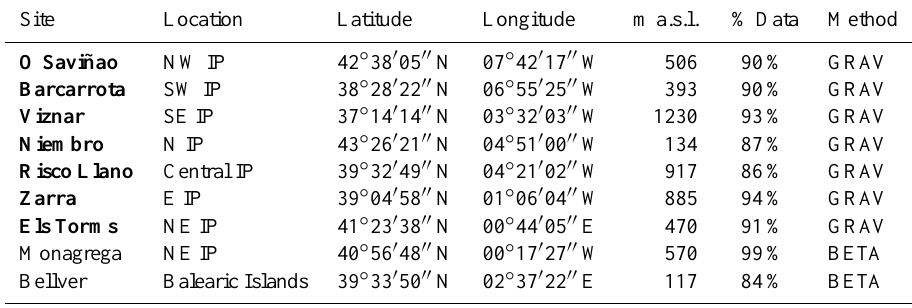
Table 1. Location, PM 10 daily data availability during the 2001–2011 period and measurement methods used in the air quality monitoring sites of this study (EMEP stations in